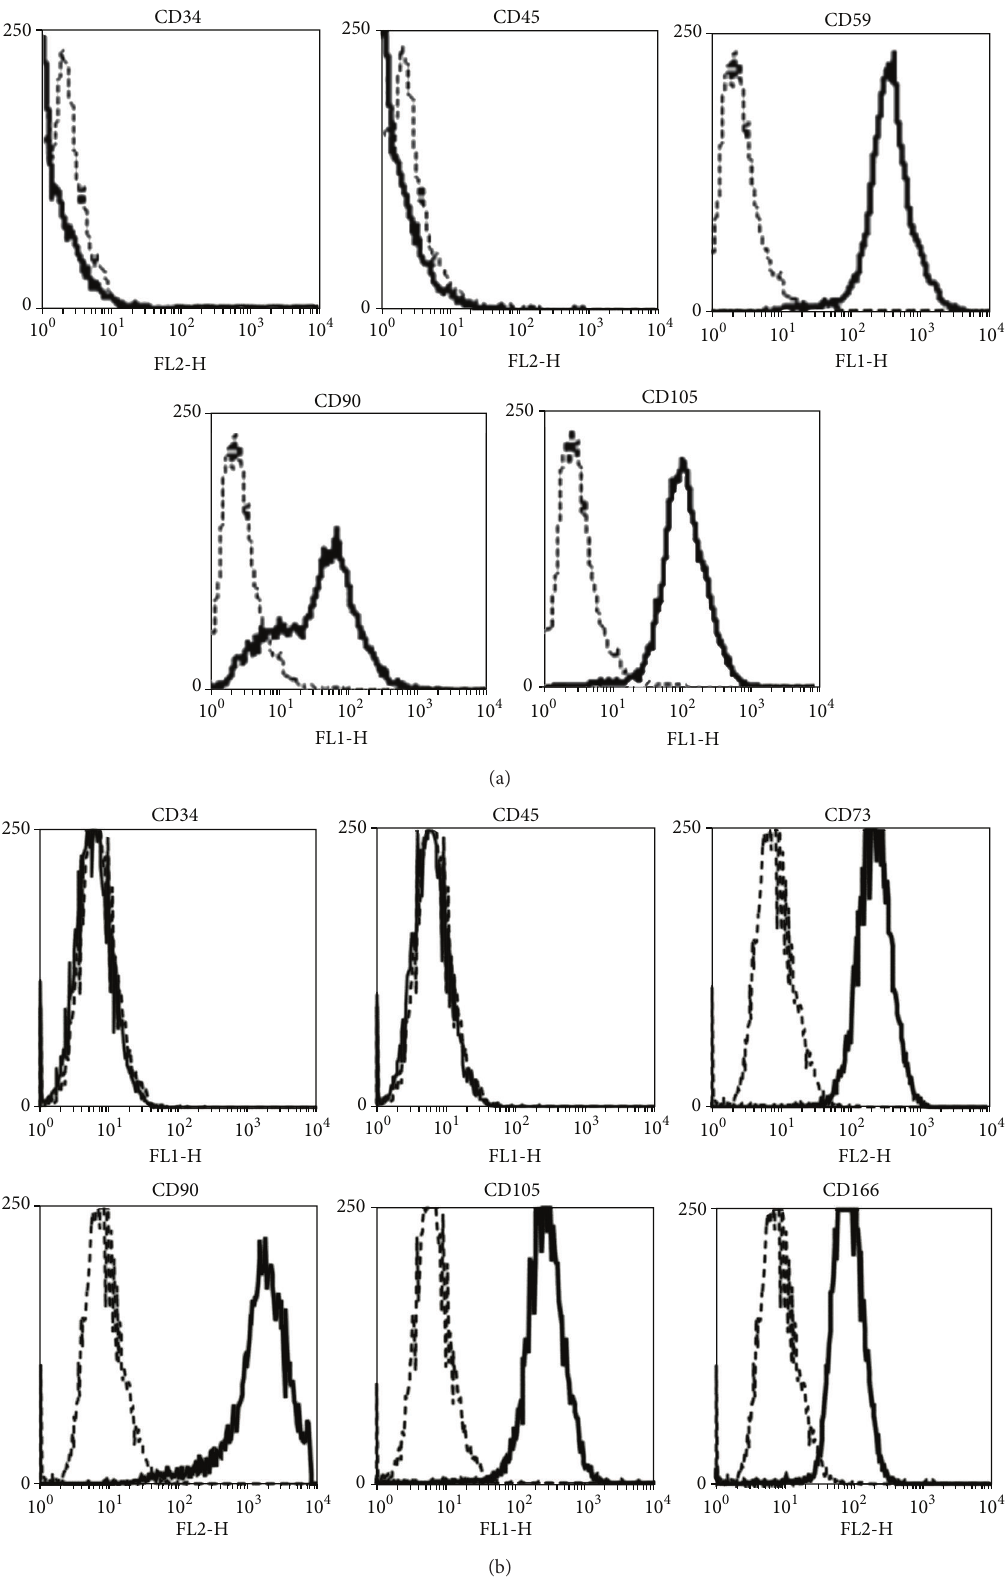
Figure 2: Characterization of adult stem cells. Flow cytometric analysis revealed a CD34 − , CD45 − and CD59 + , CD90 + , CD105 + pattern for hASCs (a) and a CD34 − , CD45 − and CD73 + , CD90 + , CD105 + , CD 166 + pattern for hBMSCs (b). The isotype controls are indicated with dashed